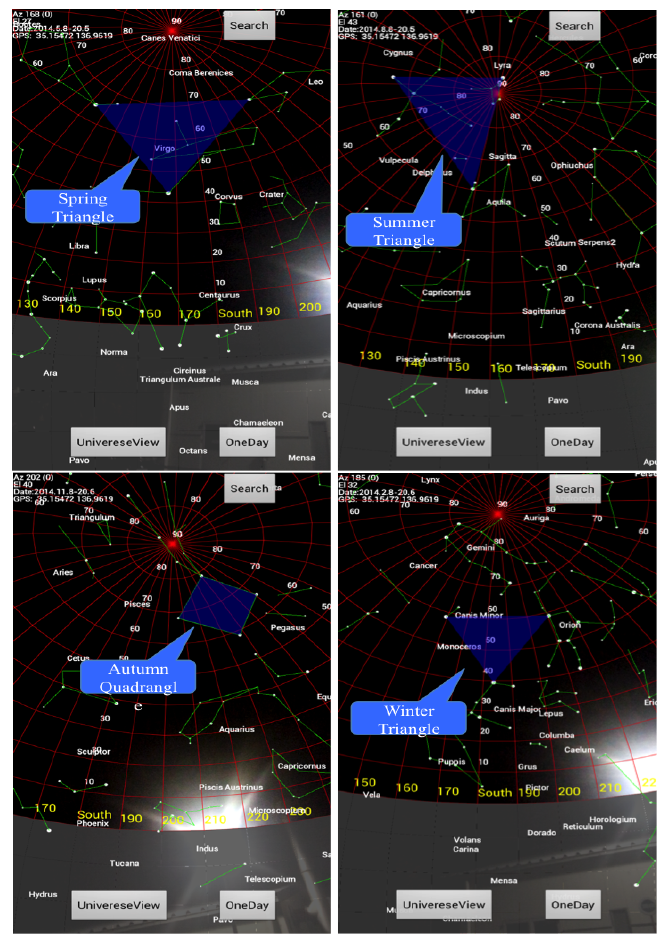
Figure 6. The seasonal constellation of the southern starry sky in spring: ( upper left ) spring constellations; ( upper right ) summer constellations; ( bottom left ) autumn constellations; ( bottom right ) winter constellations in AR